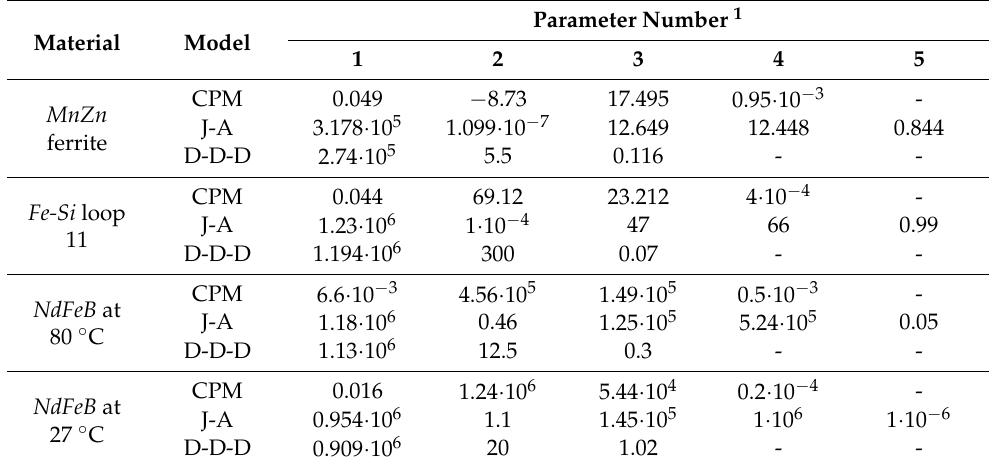
Table 1. Parameters of the considered hysteresis models for the several